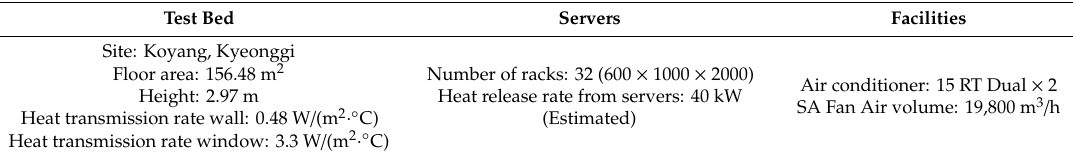
Table 1. Specifications of the computer room and servers.